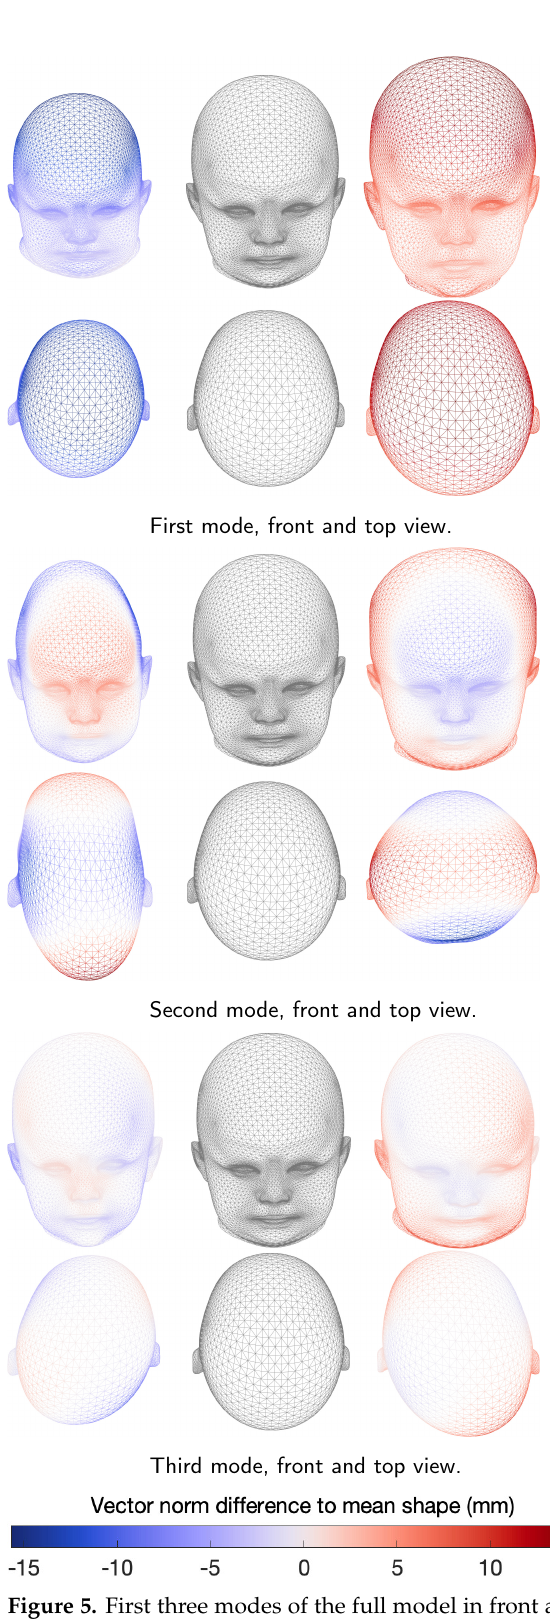
Figure 5. First three modes of the full model in front and top view. From left to right: − 3 σ , mean shape, and + 3 σ . Color bar indicates vector norm difference between principal component shape and mean shape